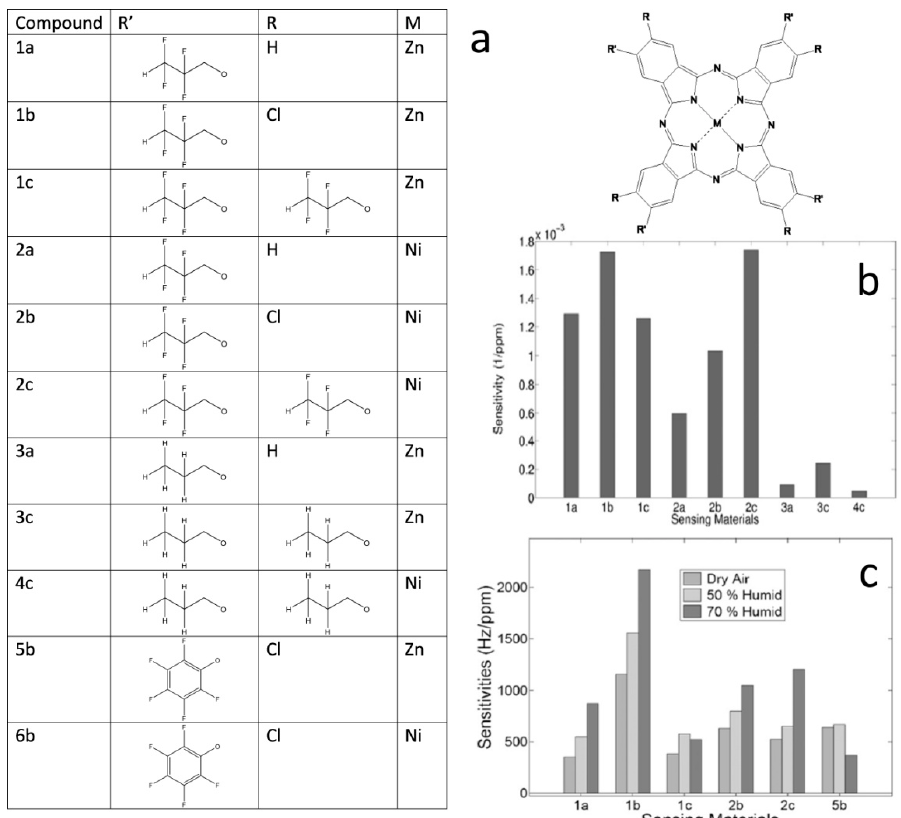
Figure 18. Chemical structures of phthalocyanines with R and R ′ substituents ( a ). DMMP sensitivities of phthalocyanines having fluorinated and non-fluorinated substituents as obtained with QCM sensors in dry air ( b ) and SAW sensitivities ( c ) for the selected compounds. Adapted from [110] with permission from Elsevier.